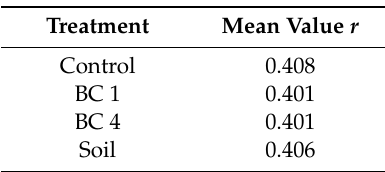
Table 9. Reproductive test with Moina macrocopa (7 days). n = 5.